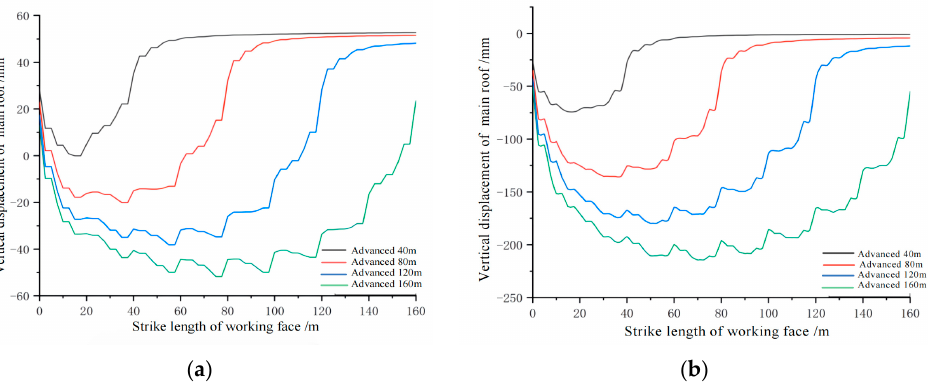
Figure 8. The evolution characteristics of main roof displacement. This figure shows the relationship between vertical displacement of main roof and the advanced length of the working face in filling 1/3 and no filling. ( a ) Filling 1/3; ( b ) No filling.